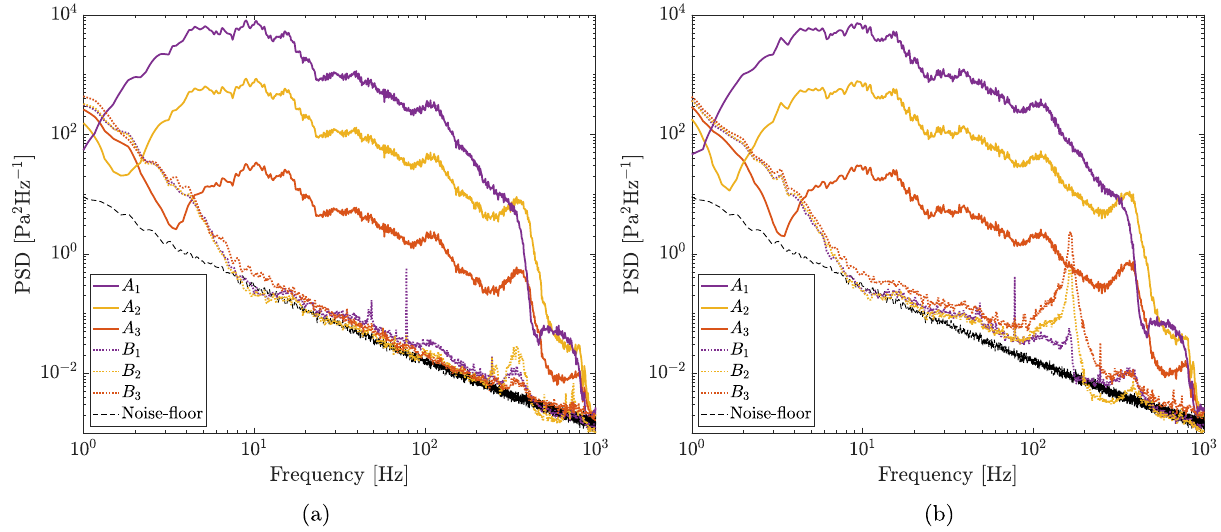
Figure 9. Power spectrum density of the acoustic pressures at all microphones for p 0 = 2.75 bar and p f = 5.0 bar with 20 m PU tube termination (a) and closed-end termination (b). The initial gas volume is V 0 = 2.00 dm 3 and the fi nal gas volume is calculated